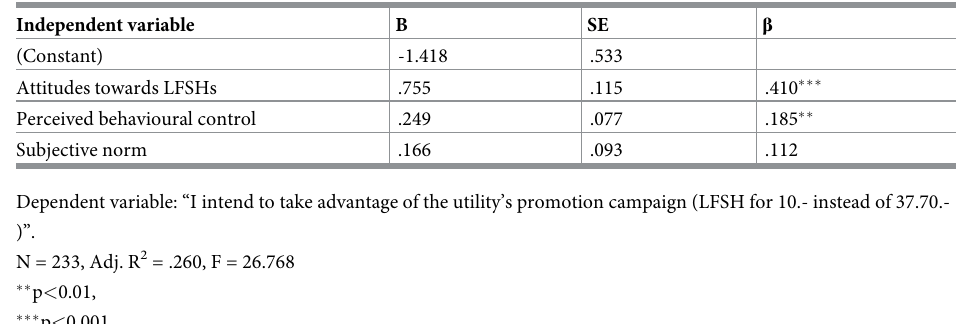
Table 3. Linear regression to explain the intention to purchase an